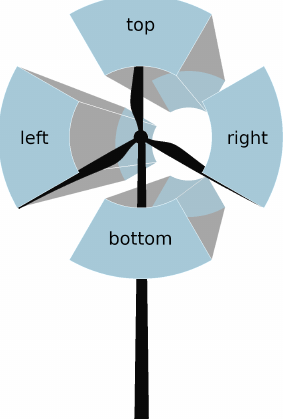
Figure 1. Schematic illustration of the top sector and the bottom sector, as well as the left and right sectors, defined from a view looking downwind towards the wind turbine on the